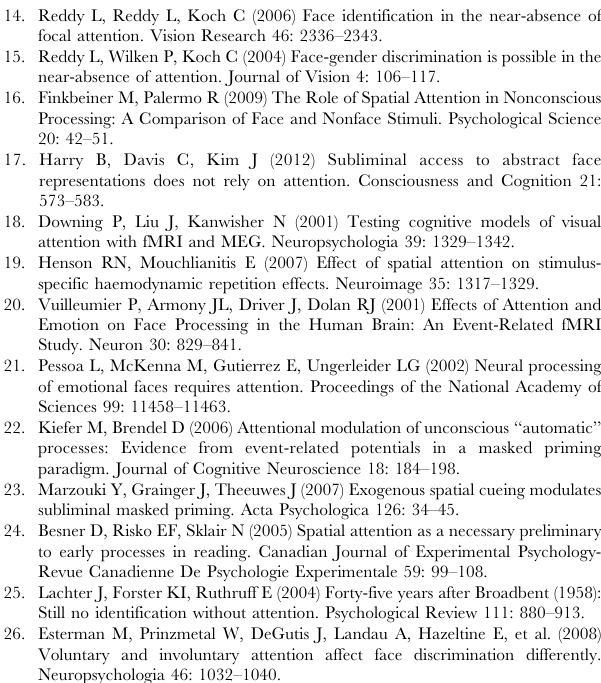
influenced by the information that is accumulated during the initial movement as it is by the information present at the beginning of the initial movement. For this reason, we have chosen to depict initial x-velocity as a function of LiftOff Latency as opposed to Total Duration. (TIF) Figure S3 Correlation of the MCE and d’ for short SOA (A) and long SOA (B) trials. As in Expt 1A, we assessed the relationship between the MCE and prime visibility by regressing a Standardised Priming Index (SPI) over d’ values for each level of SOA. d’ did not significantly predict SPI in either case. (TIF) Figure S4 Conditional mean durations of the initial 20% of Expt 1B trajectories, shown as a function of Target-Viewing Time. As in Expt 1A, we inspected the conditional mean durations of the selected analysis period for Expt 1B (initial 20% of trajectories). Again, duration decreases as a function of Target-Viewing Time, with later LiftOff Latencies corresponding to shorter durations for the initial 20% of the response. To assess whether the total duration (LiftOff Latency +- duration of initial 20%) was a better predictor of initial x-velocity than just LiftOff Latency, we compared a Linear Mixed Effects Model (LMM) that included LiftOff Latency with a model that substituted this term with Total Duration (both models have the same number of parameters). As in Experiment 1A, AIC, BIC, and Log Liklihood comparisons favoured Model 1, suggesting LiftOff Latency to be a better predictor of initial x -velocity than total duration (LiftOff Latency + duration of initial 30%).